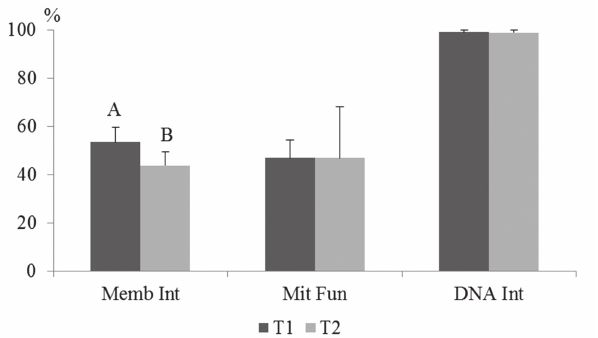
Fig. 4. Mean and standard deviation of percentage of Membrane Integrity (Memb Int), Mitochondria Functionality (Mit Fun) and DNA Integrity (DNA Int) observed in Colossoma macropomum sperm after cryopreservation.